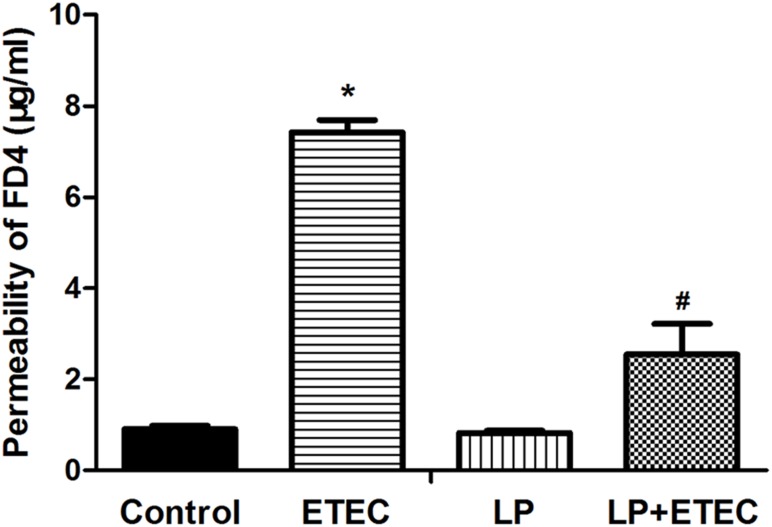
FD-4 diffusion in L. plantarum ZLP001-treated IPEC-J2 cells. Cells were left untreated or pretreated with L. plantarum ZLP001 (LP, 108 CFU mL−1) for 6 h on the apical sides of the cell monolayers and then challenged or not with 106 CFU mL−1 ETEC for 3 h. FD-4 concentrations in the basal compartments were measured. Values are shown as the means ± SE of three independent experiments. ∗P < 0.05 vs. non-treated controls; #P < 0.05 vs. ETEC alone.